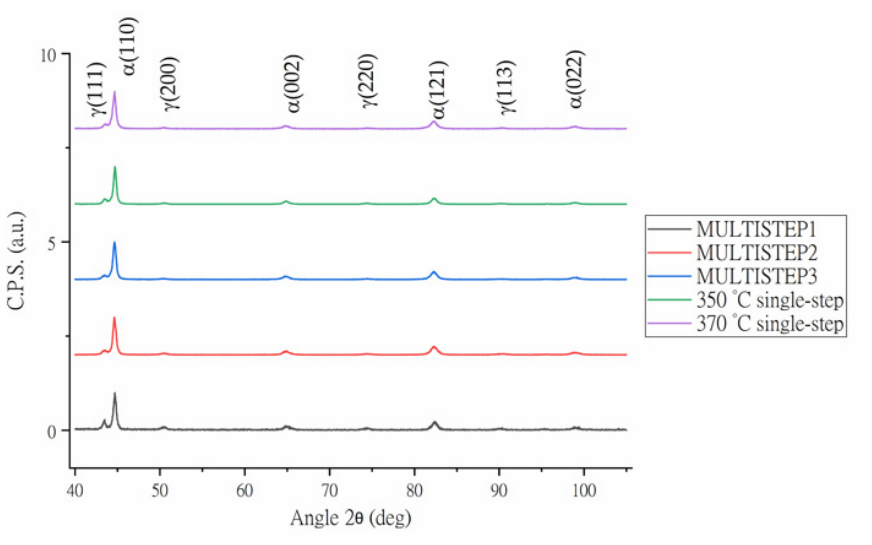
Figure 9. XRD patterns for the different heat treatment routes. Table 5. Variations in volume fraction of retained austenite and carbon concentration (c γ ) as a function of the austempering cycle of the investigated